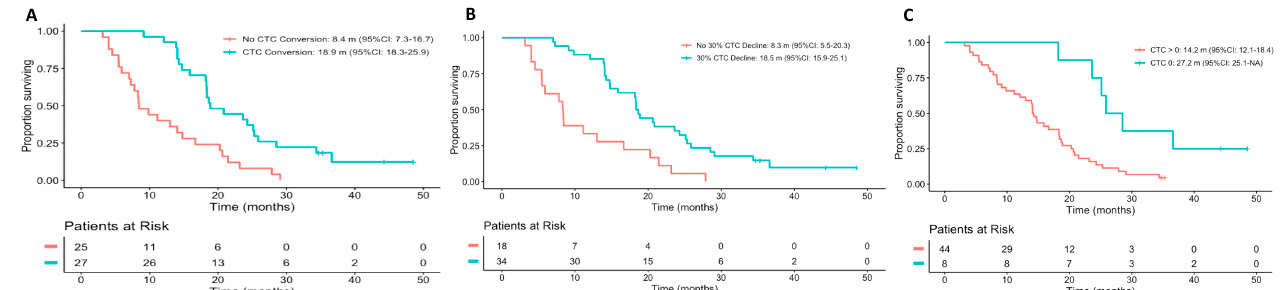
Figure 2. Kaplan–Meier plots for overall survival according to CTC measured as ( A ) CTC conversion from ≥ 5 CTC/7.5 mL to <5 CTC/7.5 mL; ( B ) 30% CTC decline from baseline and ( C ) conversion from ≥ 1 CTC/7.5 mL to 0 CTC (CTC0). Abbreviations: CTC, circulating tumor cell; m, months. Table 4. Median overall survival, hazard ratios and c-index values for CTC and PSA response endpoints.